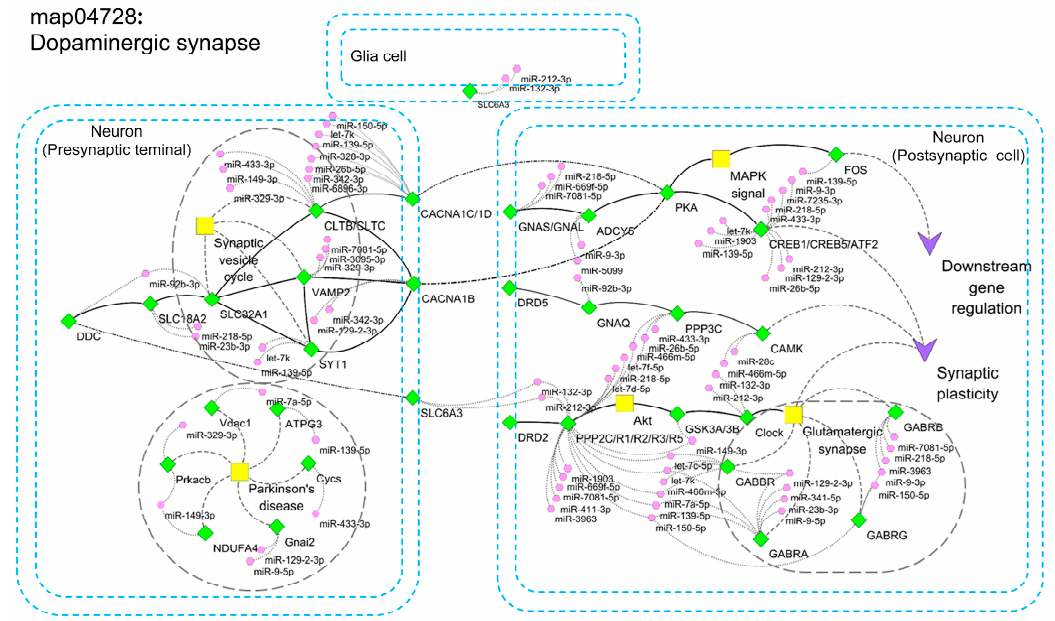
Figure 6. Network of miRNA-target pathways involved in dopaminergic synapse for up-regulated miRNAs. The rhombus represents the genes, hexagon represents the miRNAs and the square represents the main pathways in dopaminergic synapse. The solid lines with arrows represent the relationship between genes and pathways, and the dot lines represent the relationship between genes and miRNAs. The solid lines without arrows represent the sub-pathways. The double blue solid line represent the cell structure of neuron (presynaptic terminal and postsynaptic cell) and glia cell.